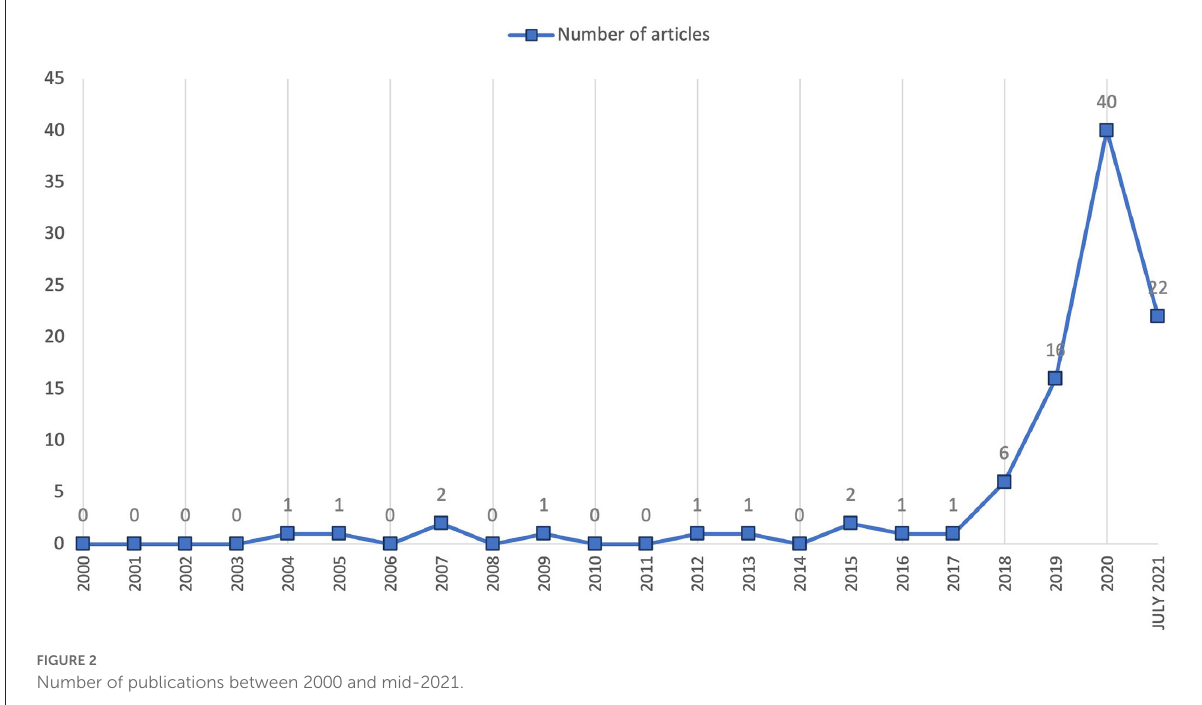
FIGURE2 Number of publications between 2000 and mid-2021.